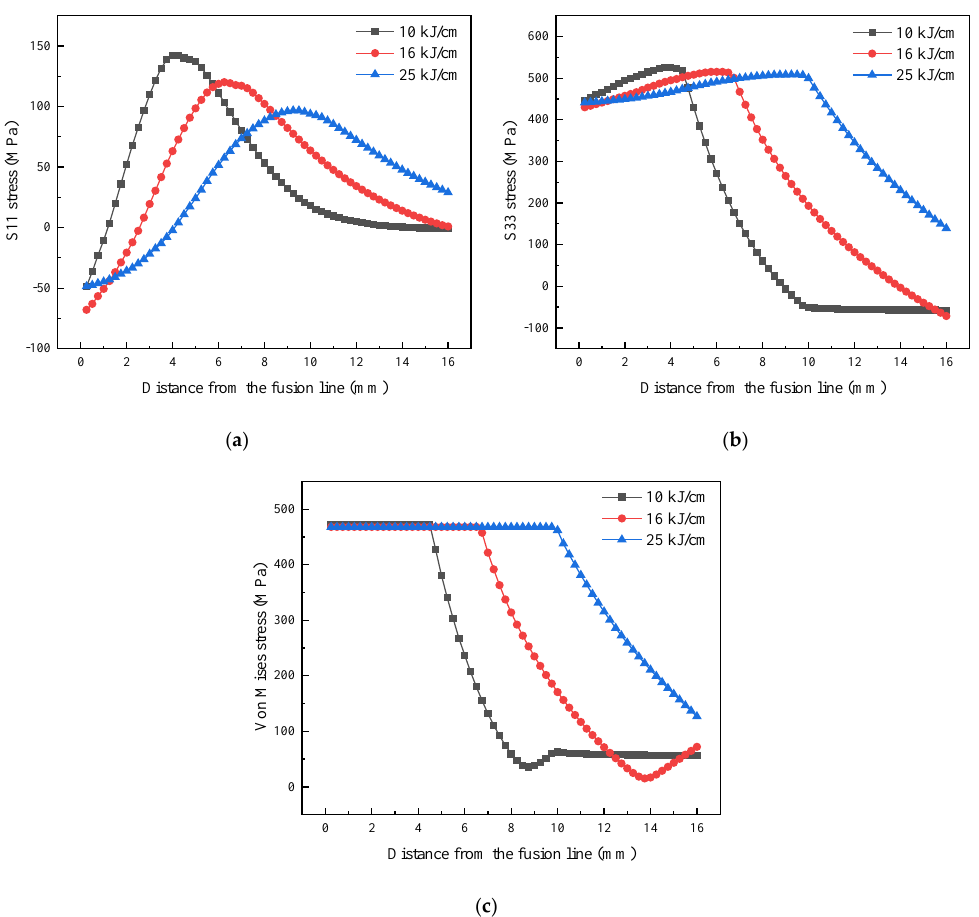
Figure 20. Stress distribution at a depth of 0.5 mm in the HAZ at the end instant of cooling for different linear energy: ( a ) S11 stress in the HAZ; ( b ) S33 stress in the HAZ; ( c ) Von Mises stress in the HAZ.